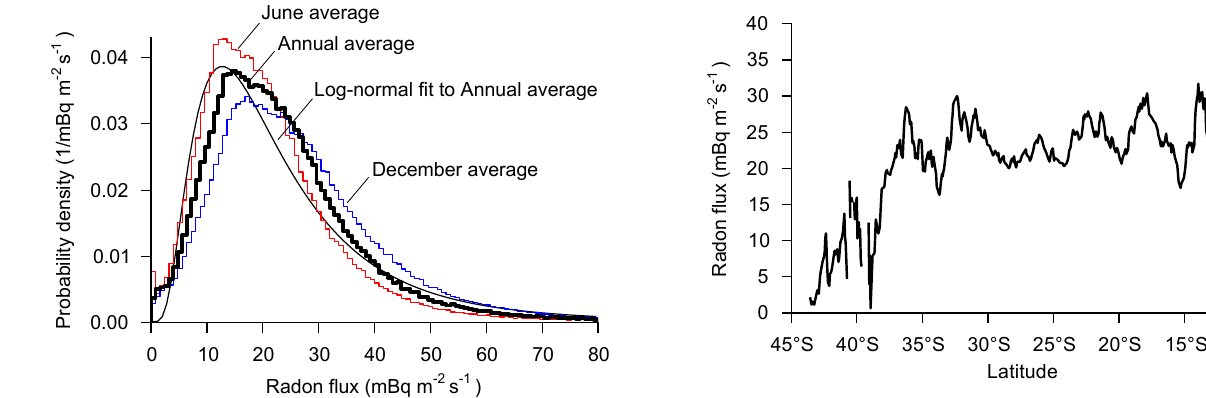
Fig. 8. Histograms of radon flux density maps. A theoretical distri- bution is fit to the July 1979–June 2010 mean flux by computing a log-normal distribution with the same mean and standard deviation of log J , where J is radon flux density, as the map.